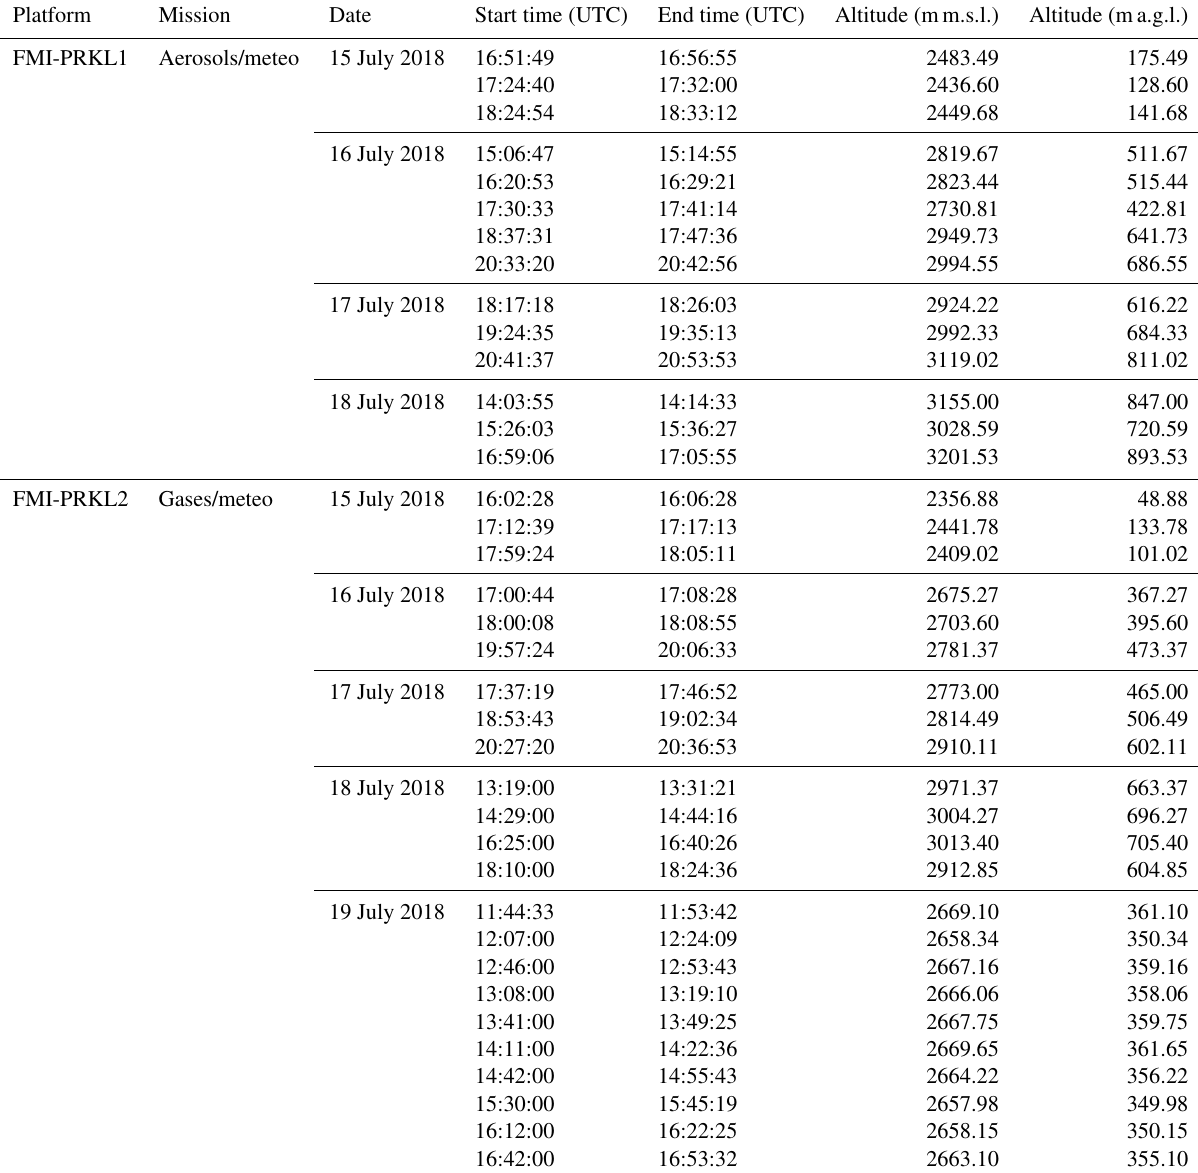
Table 2. UAS vertical profile measurements – an overview of platforms, missions, flight times, and achieved altitudes. Platform